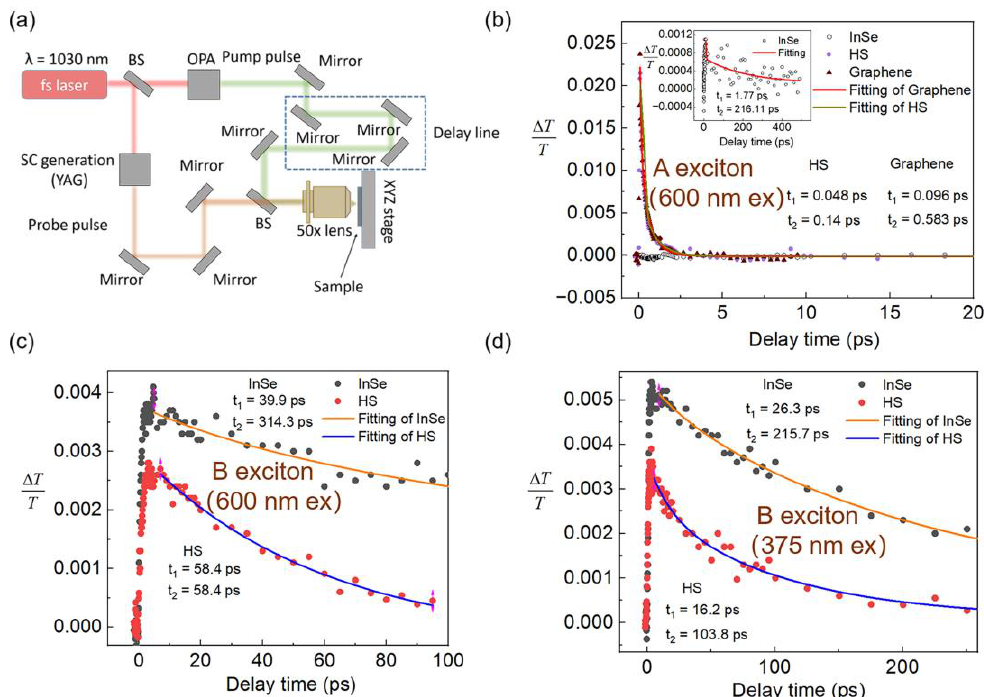
Figure 3. ( a ) Schematic diagram of the micro-area TA setup. ( b ) TA dynamics of graphene, InSe and G/InSe HS with pump and probe wavelengths of 600 nm and 844 nm (A exciton), respectively. ( c ) TA dynamics of InSe and G/InSe HS with pump and probe wavelengths of 600 nm and 502 nm (B exciton), respectively. ( d ) TA dynamics of InSe and G/InSe HS with pump and probe wavelengths of 375 nm and 502 nm (B exciton),